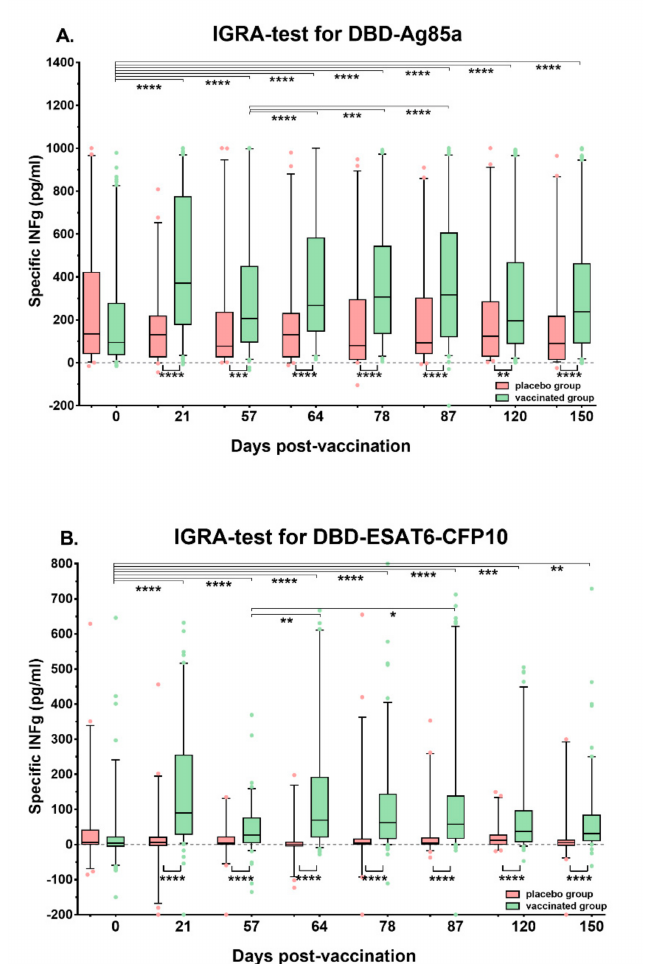
Figure1. Dynamicsofinterferongamma(INF- γ )productionafterwhole-bloodstimulationinvolunteers and the placebo group, performed with an in-house INF- γ release assay (IGRA) on study days 0, 21, 57, 64, 78, 87, 120, and 150. ( A ). Stimulation of samples with DBD-Ag85a; ( B ). Stimulation of samples with DBD-ESAT6-CFP10; medians and interquartile ranges are shown. * p < 0.05, ** p < 0.01, *** p < 0.001, **** p <